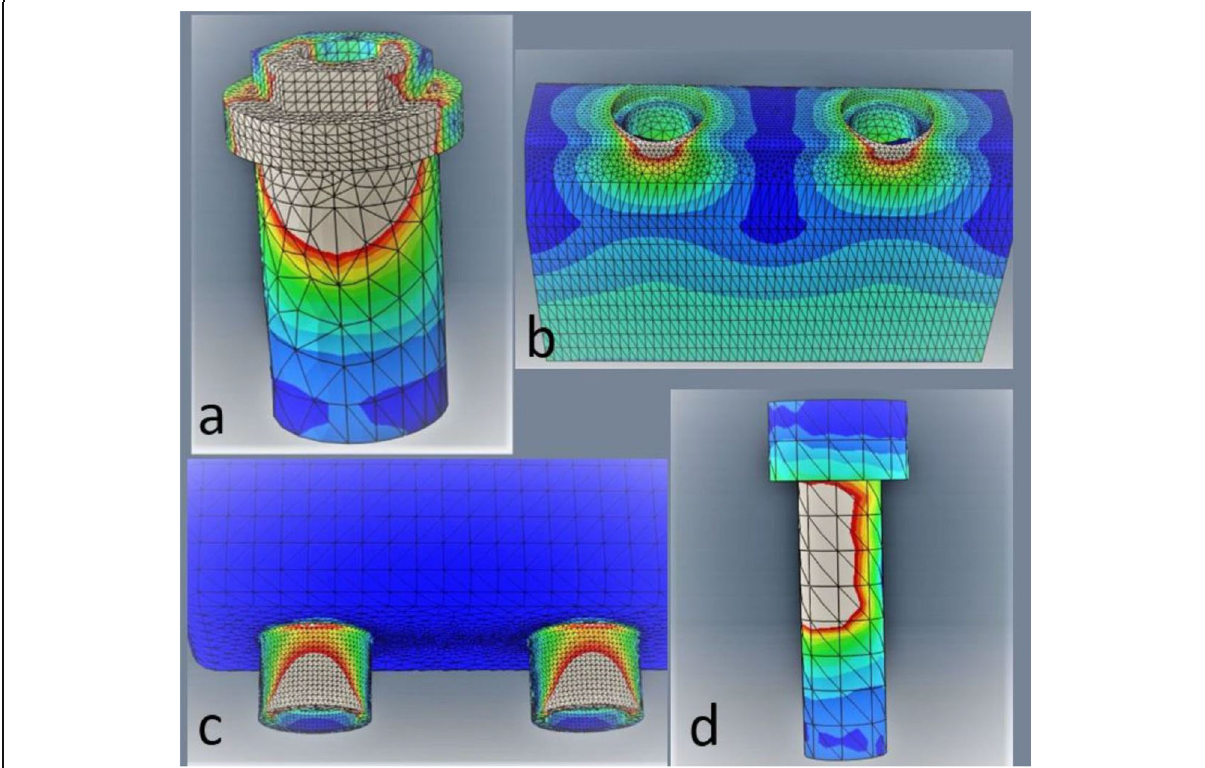
Fig. 4 Stress pattern in the reference model: a Short implants. The grey areas represent stresses above 60 MPa. b Bone part. The grey areas present stresses above 30 MPa. c Prosthetic framework. The grey areas represent stresses above 150 MPa. d Prosthetic screws. The grey regions present stresses above 200